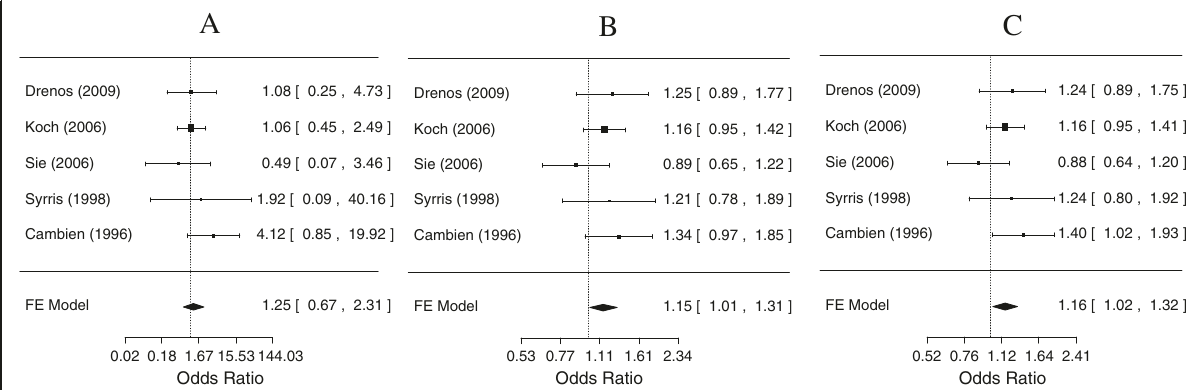
Figure 3 Meta-analysis for coronary heart disease risk depending on the rs1800471 (913 G/C) polymorphism in the TGFB1 gene. ORs and corresponding 95% confidence intervals (CIs) are shown. Fixed effects were reported because no significant heterogeneity between studies was observed. A . Comparison of the homozygous CC genotype with the wild type GG genotype ( p =0.49); B . Comparison of the heterozygous GC genotype with the wild type GG genotype ( p =0.03); C . Comparison of the GC+CC genotype with the wild type GG genotype ( p